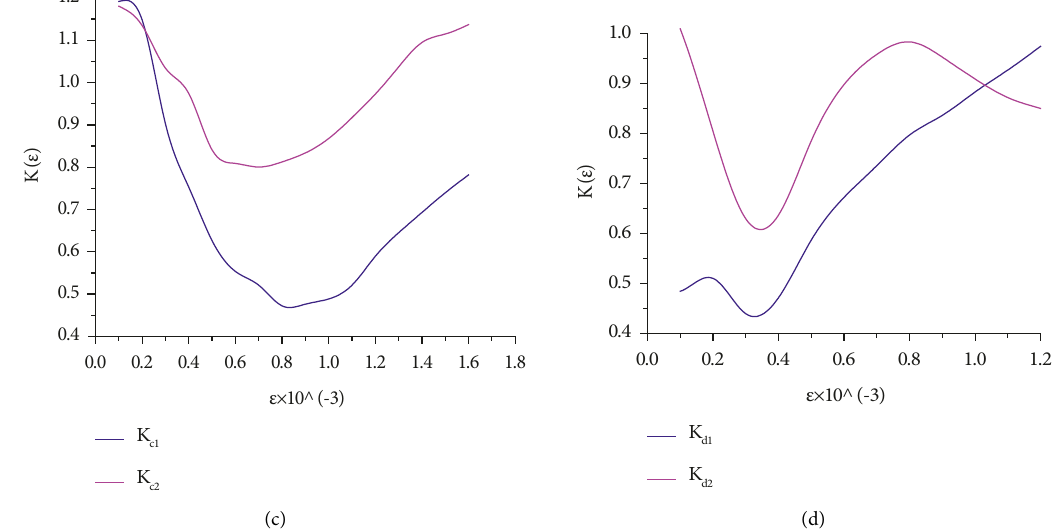
Figure 8: Softening curves. (a) Softening curves of K a 1 ( ε ) and K a 2 ( ε ). (b) Softening curves of K b 1 ( ε ) and K b 2 ( ε ). (c) Softening curves of K c 1 ( ε ) and K c 2 ( ε ). (d) Softening curves of K d 1 ( ε ) and K d 2 ( ε